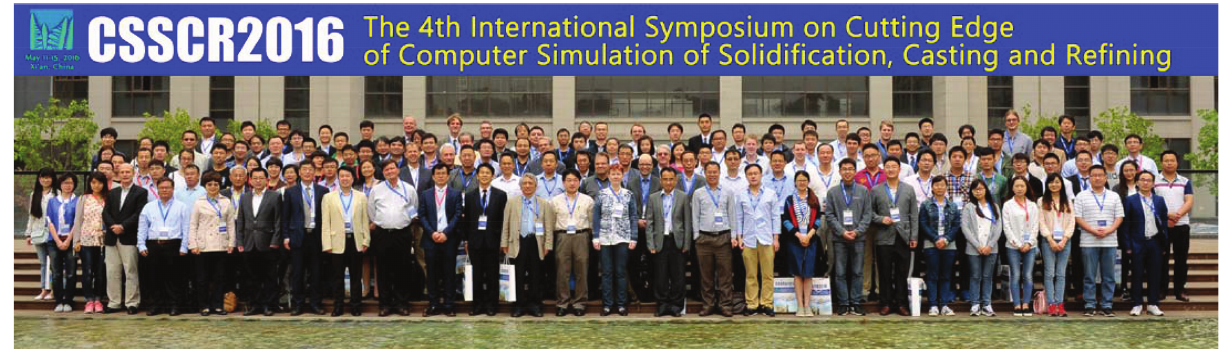
Figure 1: The fourth International Symposium on Cutting Edge of Computer Simulation of Solidification, Casting and Refining (CSSCR2016) on May 11 to 15, 2016 by Northeastern University and Xi ’ an University of Architecture and Technology in Xi ’ an,